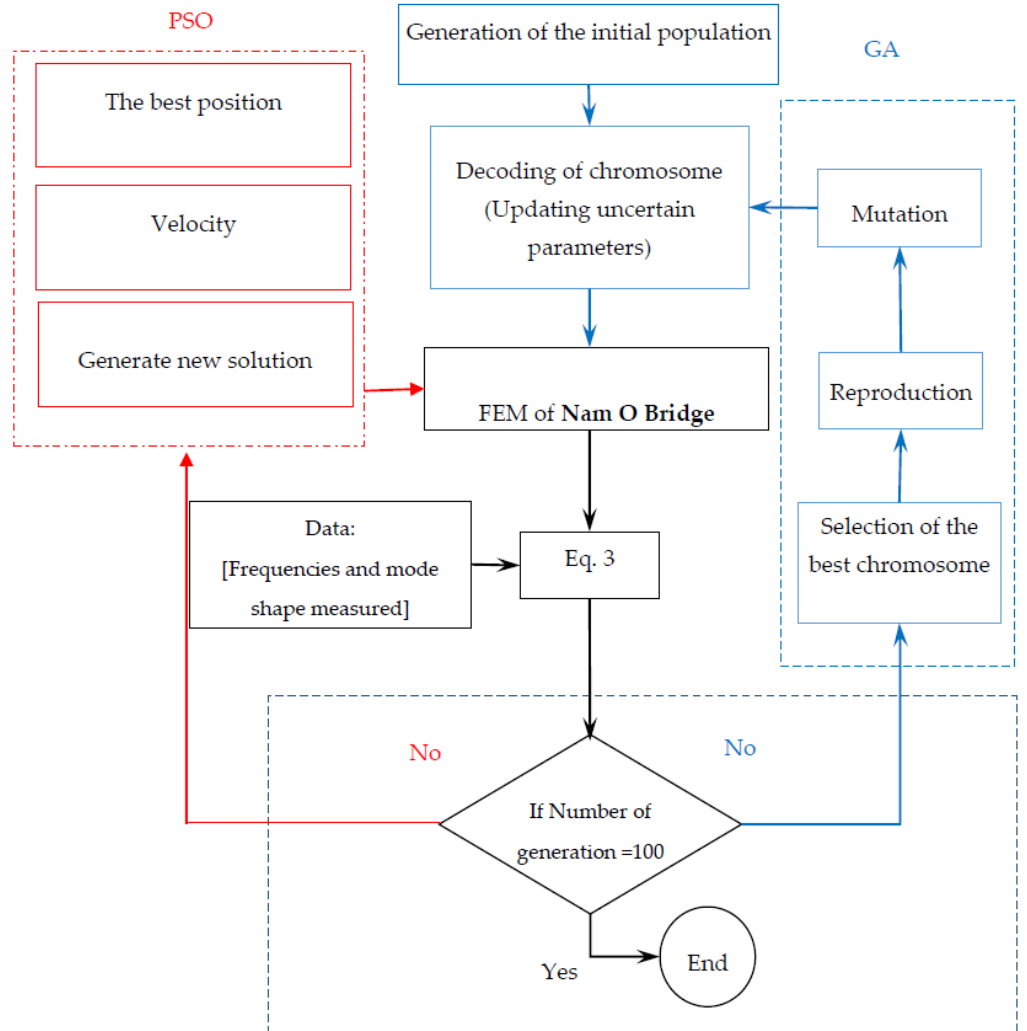
Figure 16. Methodological approach for model updating by using genetic algorithm (GA) and particle swarm optimization (PSO).